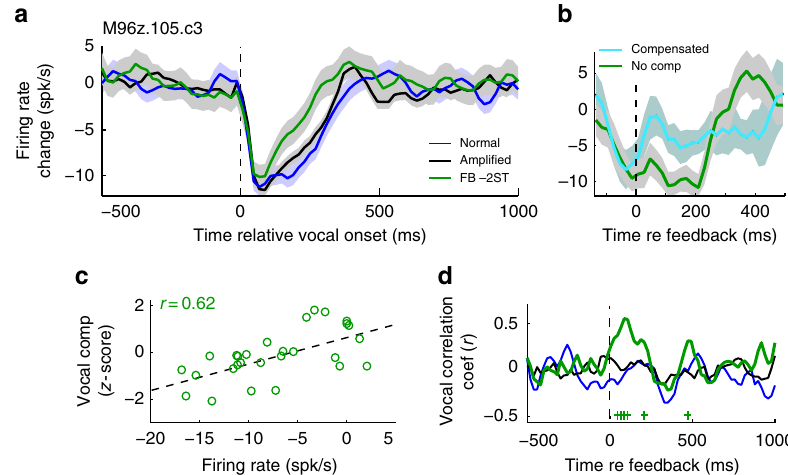
Fig. 3 Neural prediction of vocal compensation. a A sample multi-unit (MUA) PSTH of a single recording site is shown in response to a − 2ST shift. b Splitting feedback responses into compensated and no compensation trials (vocal compensation z -score > 0 vs. <0) showed an early increase in activity during compensated trials that preceded vocal compensation (which occurs >200 ms). c Correlation between feedback responses (0 – 200 ms) and future vocal compensation (>200 ms, r = 0.62, p < 0.001). Linear regression fi t is shown (dashed). d Sliding-window analysis showed that this correlation did not develop until after feedback onset and lasted until the start of vocal compensation ( + p < 0.05). Sample sizes and statistical details may be found in